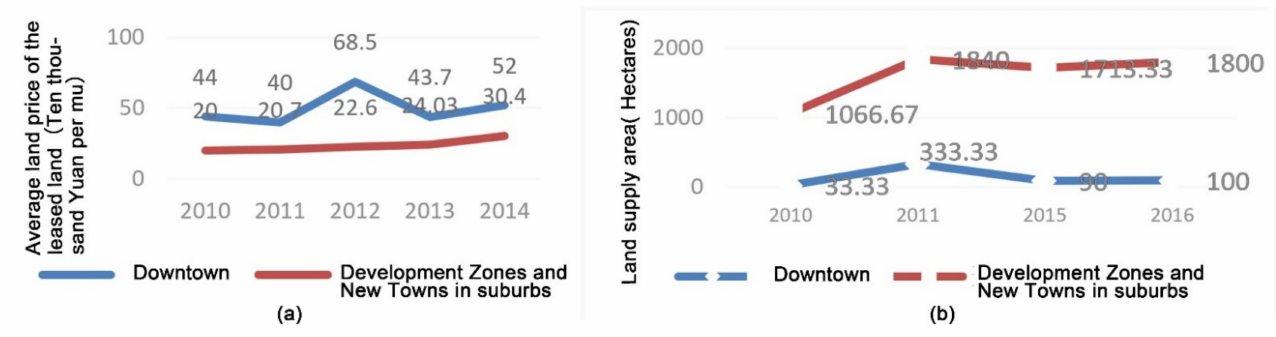
Figure 5. Analysis of manufacturing land transfer in the Wuhan metropolitan area: ( a ) average land price of the leased land; ( b ) land supply